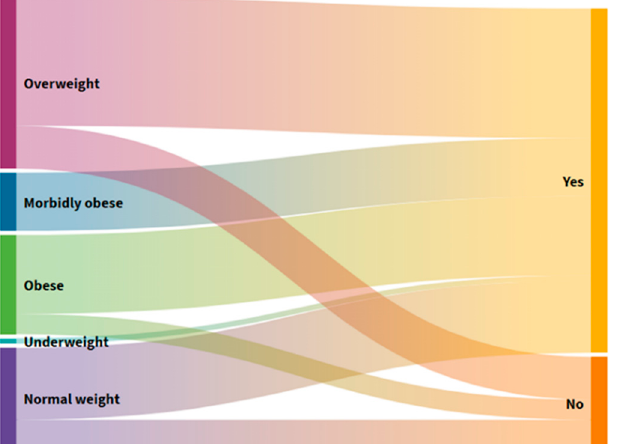
Figure 6. Alluvial diagram of the distribution of users by individual BMI groups and consumption of more than three different drugs.